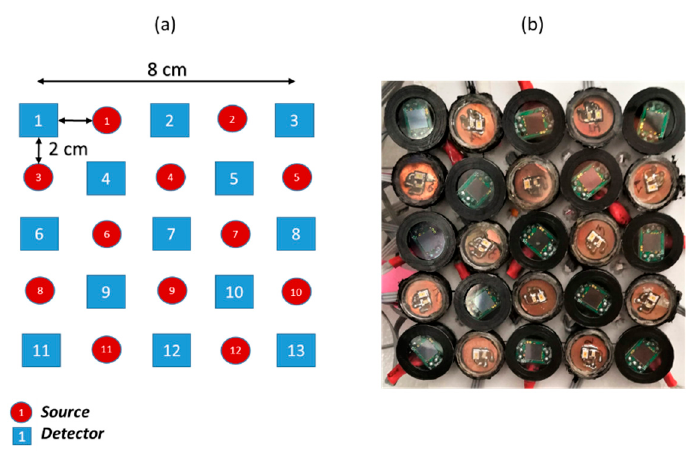
Figure 1. ( a ) Arrangement scheme of light source and detectors (top view). ( b ) Silicon photomultiplier (SiPM) and light emitting diode (LED) holders (bottom view).